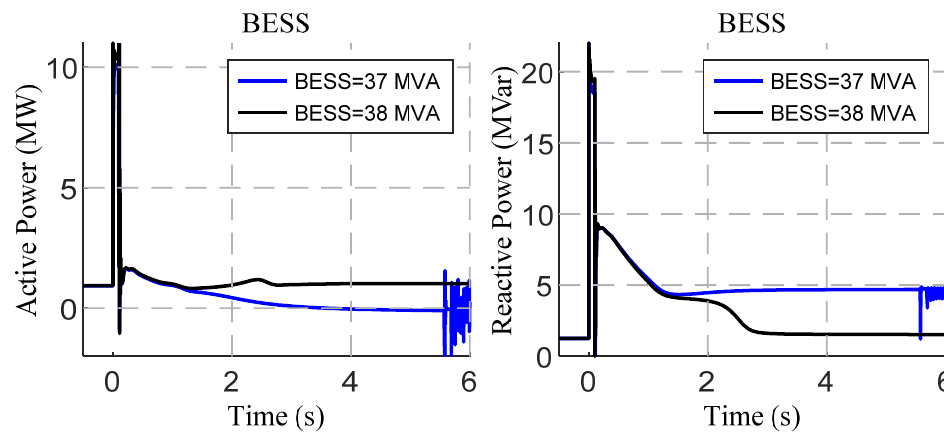
Figure 9. L3 small industrial motor speed and reactive power consumption—base case scenario.